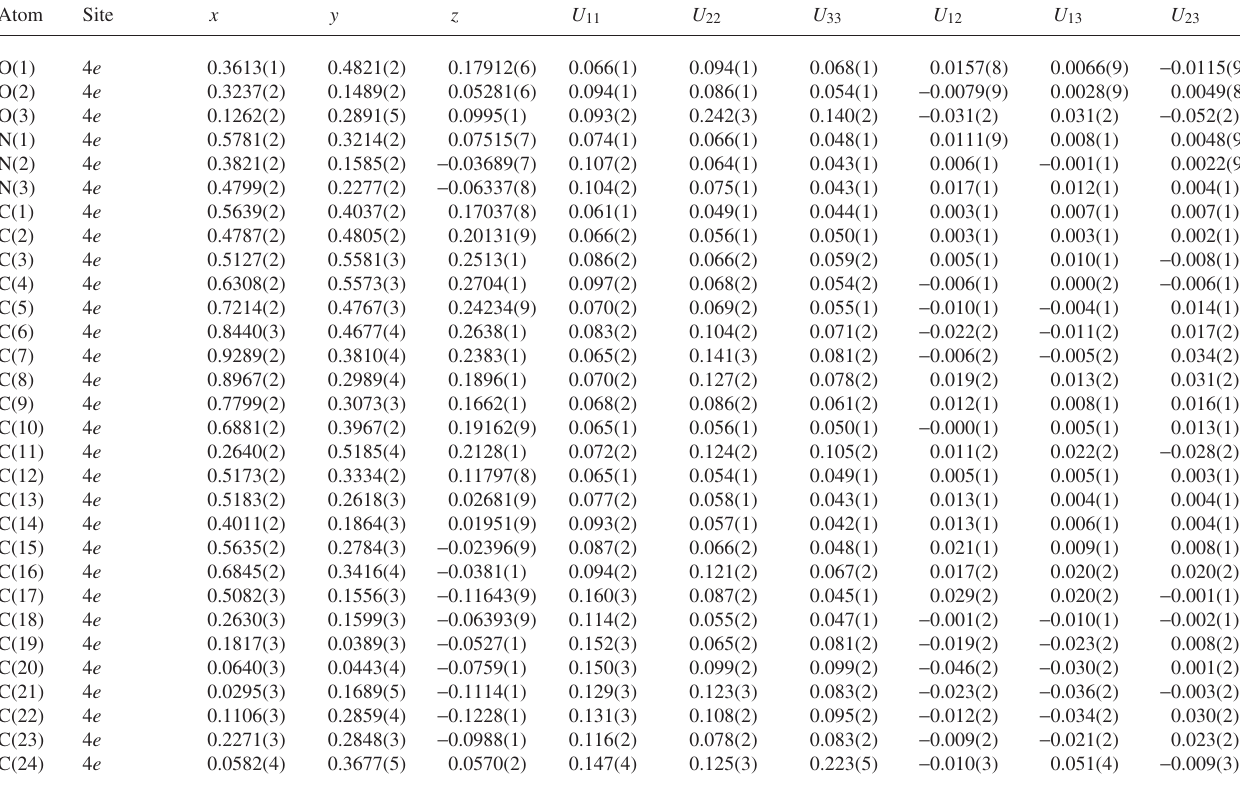
Table 3. Atomic coordinates and displacement parameters (in Å 2 )